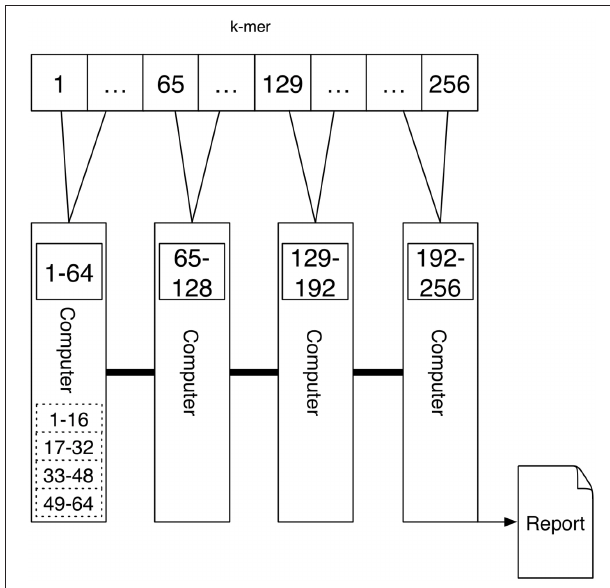
FIGURE 4 | An interconnected network of computers is given. Each computer might have a single processor or multiple processors (depicted by the dashed rectangular boxes). The task is first distributed to the four computers, where a quarter of the k -mer counts are computed. If there are multiple processors the work is further distributed to these. Because the tasks are distributed to multiple computers the report cannot be produced directly since the results are present on different devices. Using the connection between the computers one device is gathering the results using Message Passing.